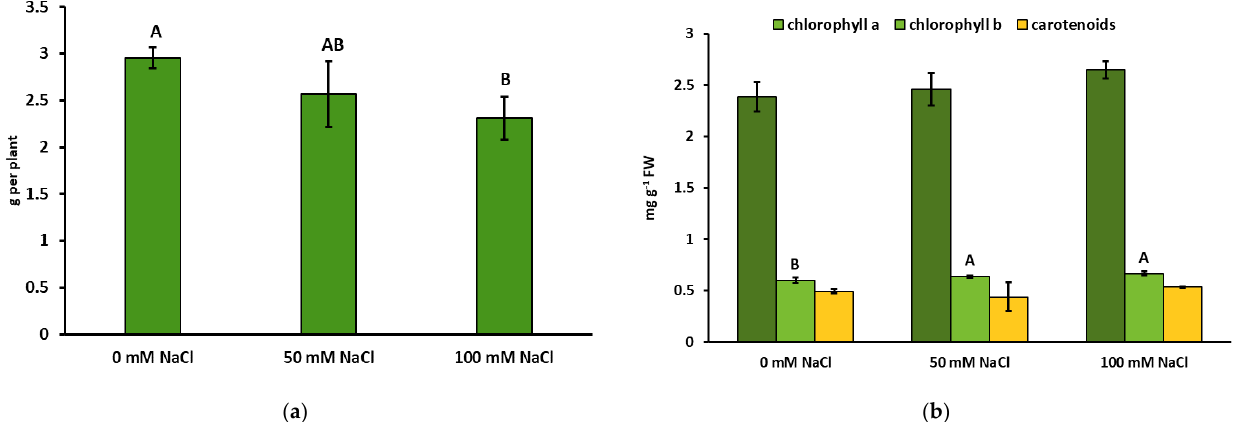
Figure 1. Effect of the NaCl concentration on ( a ) growth parameters and ( b ) concentrations of photosynthetic pigments in Melissa officinalis after 10 days of salt exposure. Data are means ± SD ( n = 16 for FW and n = 6 for photosynthetic pigments). Means followed by different letters differ statistically significantly ( p < 0.05, Tukey’s test). The absence of letters indicates that there are no significant differences.